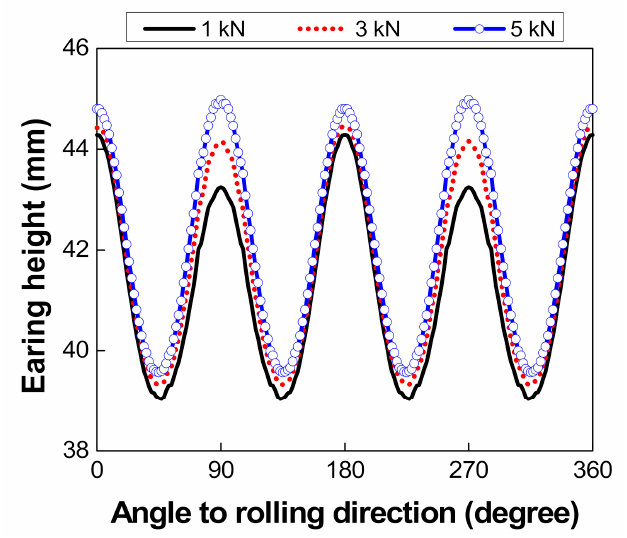
Figure 10. Results of the earing height profiles of AA1050-O using the present finite element anal- ysis (FEA) with uniform BHFs of 1 kN, 3 kN, and 5 kN.